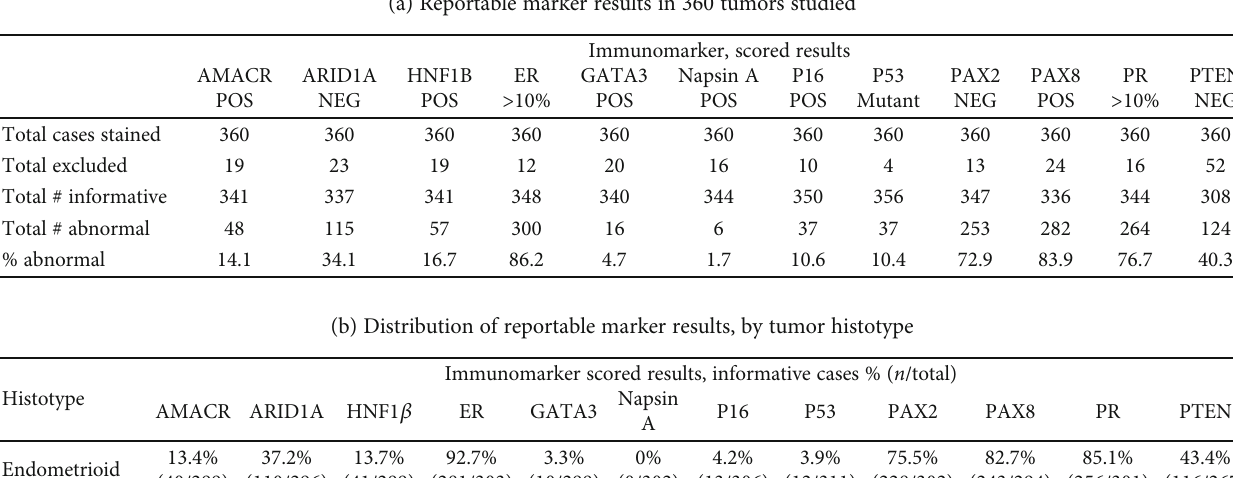
Table 2: Biomarker expression by histotype. (a) Reportable marker results in 360 tumors